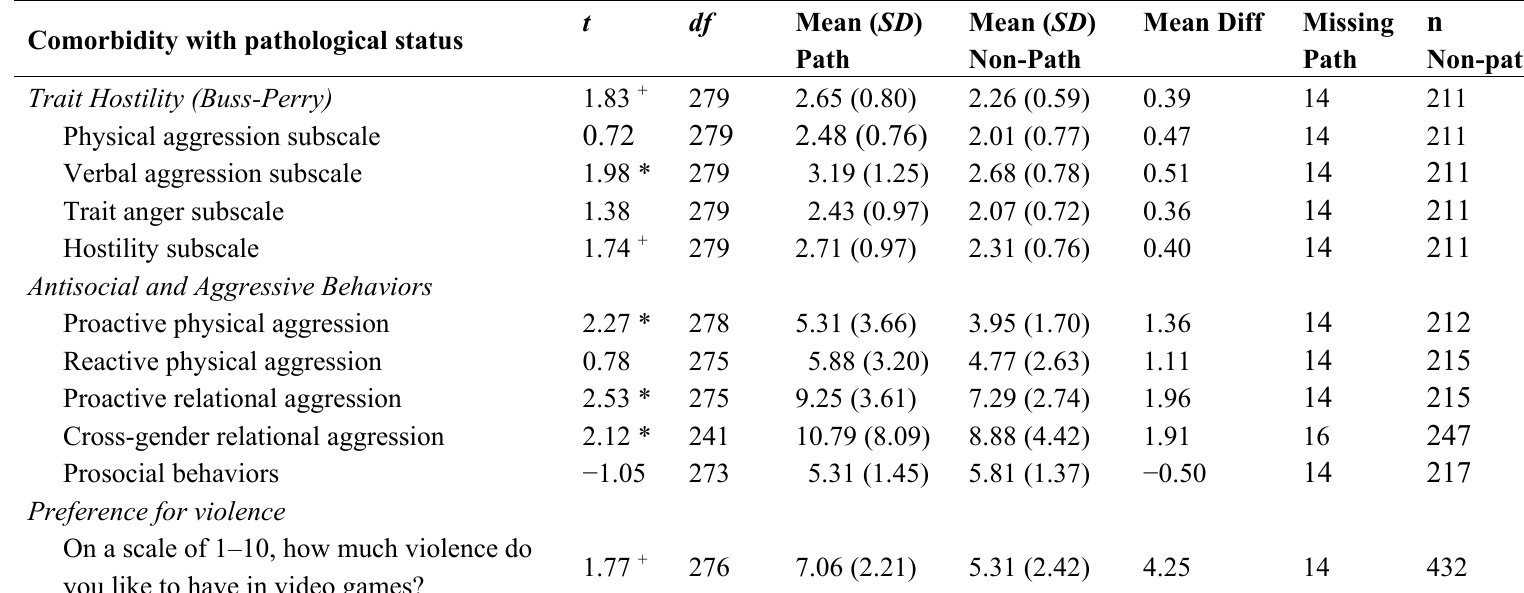
Table 4. Differences between pathological gamers and. non-pathological gamers (Study 2: Older adolescents). Comorbidity with pathological